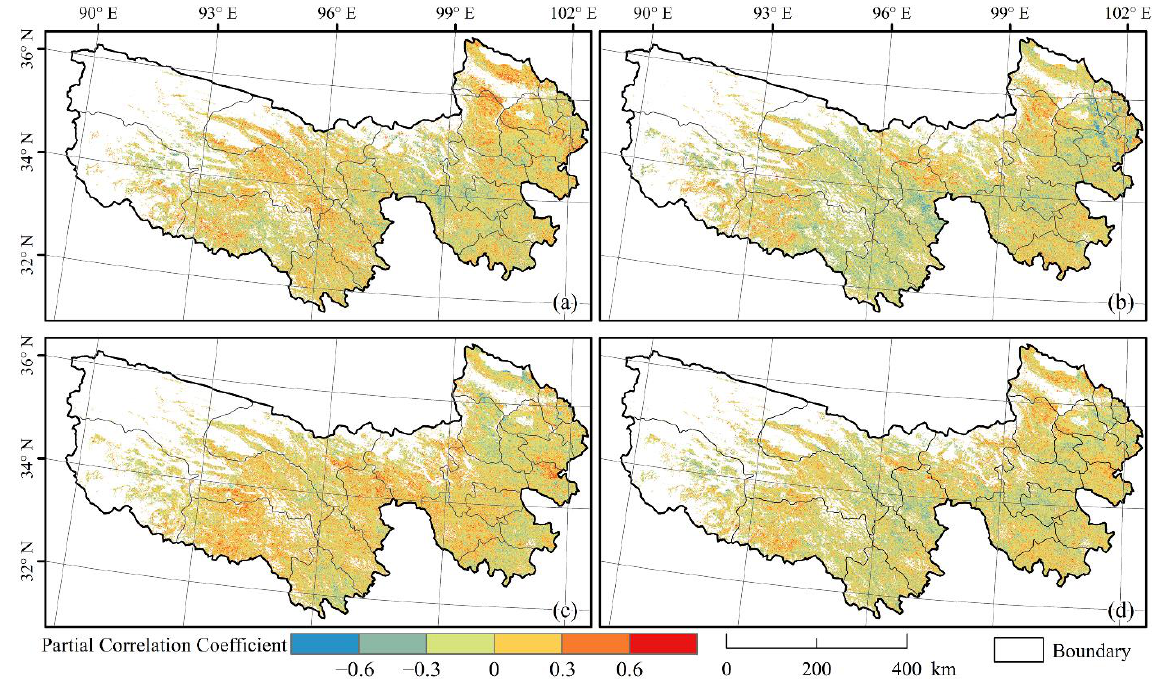
Figure 12. Spatial distribution of the partial correlation coefficients between the SOS of the vegetation and sunshine duration in March ( a ), April ( b ), May ( c ) and March – May ( d ) in the Three-River headwaters region.